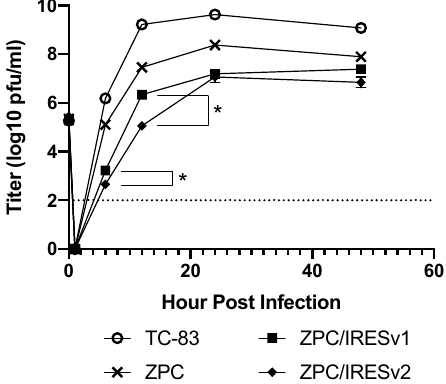
Figure 2. Log 10 -transformed in vitro replication curves. ZPC/IRES vaccine versions 1 and 2 (square and diamond, respectively), ZPC-738 (X) or TC-83 vaccine (open circles) were amplified in Vero cells in triplicate at an MOI of 0.1. Error bars denote standard error. Titers between ZPC/IRESv1 and ZPC/IRESv2 were compared and significant differences are denoted by an asterisk (*, 2-way ANOVA with Tukey multiple comparisons post-hoc test).